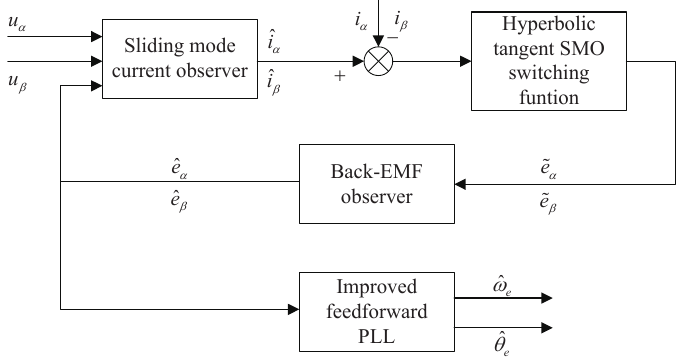
Figure 9. Structure of the PMSM position sensorless control system based on SMO.